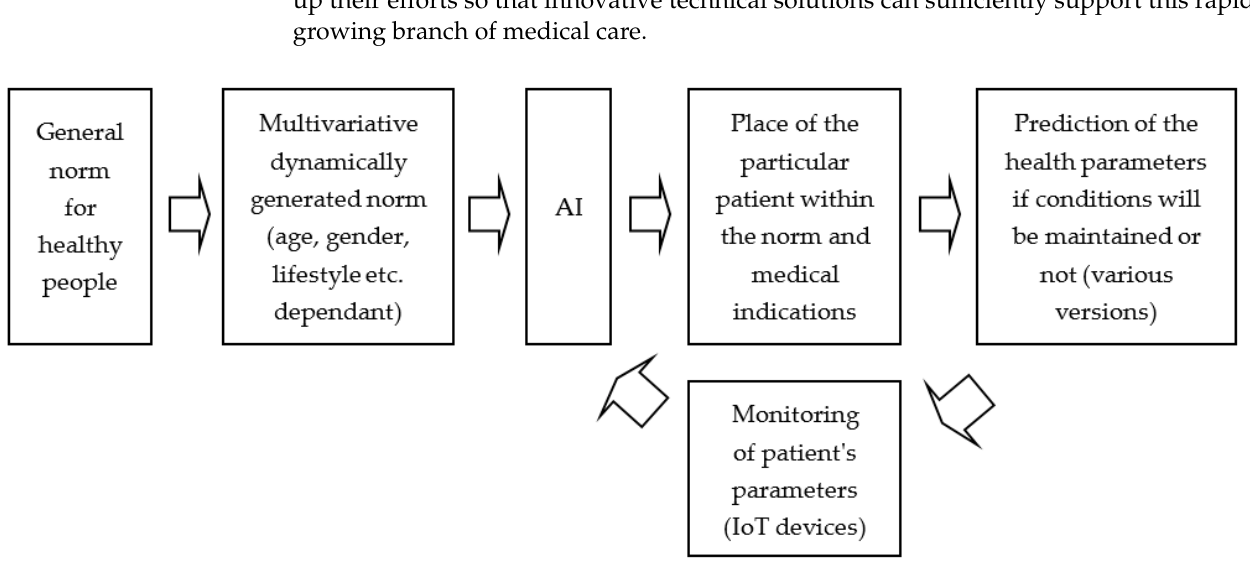
Figure 1. General idea of AI-based system of preventive medicine (own proposal).